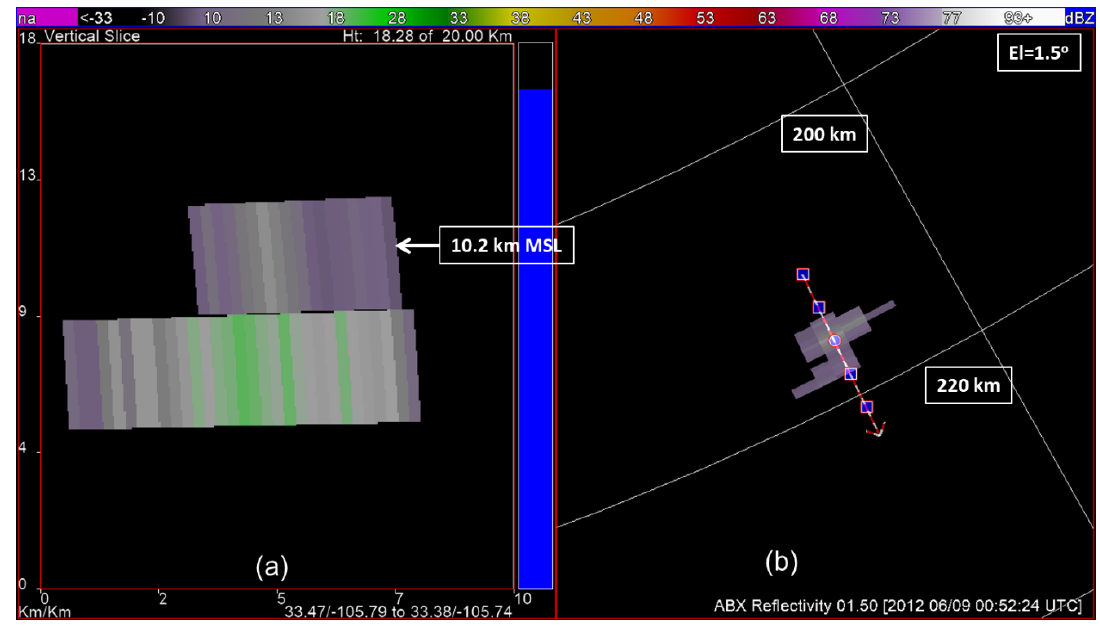
Figure 15. ( a ) Vertical cross section of reflectivity obtained with the Albuquerque WSR-88D (in New Mexico, code designation KABX). ( b ) Reflectivity field at the 1.5° elevation scan. The line with the arrow indicates the radial along which the vertical cross-section in ( a ) is plotted. The color bar indicates the reflectivity values (dBZ) and the time is 00:52 UTC. The range marks encompass the smoke. Scattergrams of Z , Z DR, and Z , ρ hv (Figure 16) are contained within approximately rectangular domains, suggesting that these variables are independent. Hence, for fuzzy logic type classification, the one-dimensional membership functions (at least for these variables) would su ffi ce.